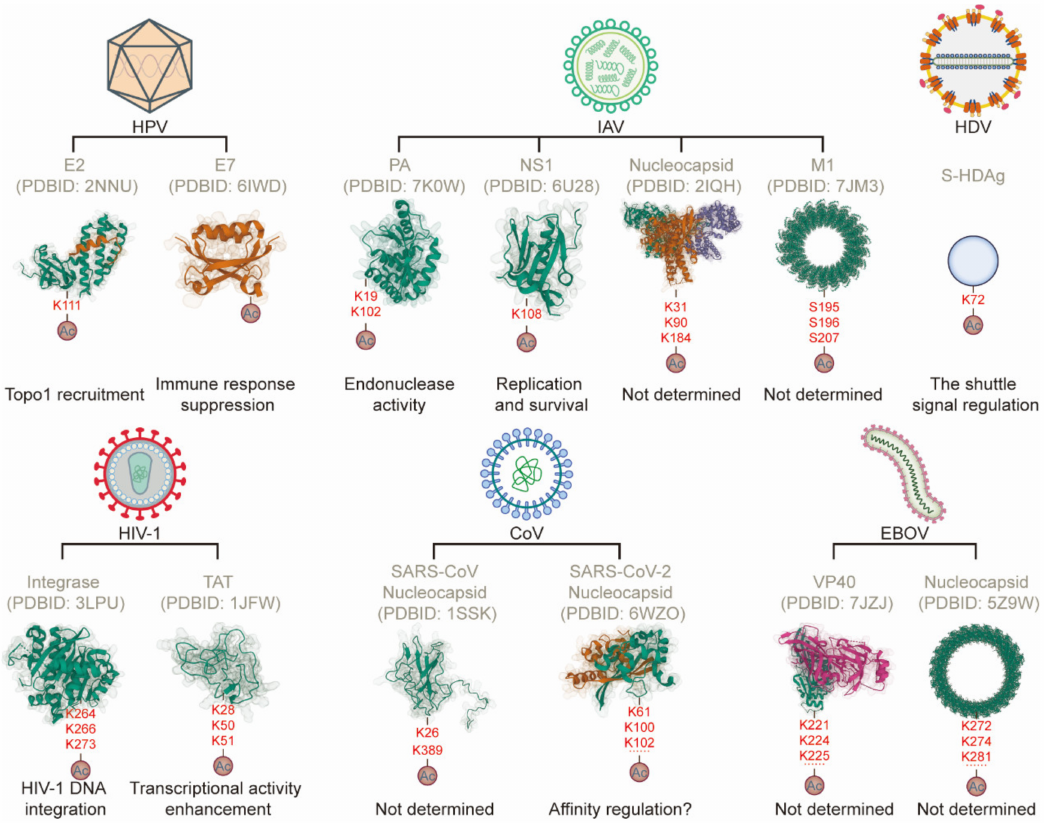
Figure 2. Effect of acetylation of viral proteins during viral infection. Representative acetylation of viral proteins and their function during virus–host interaction. The 3-D structures for the viral proteins were retrieved from the PDB database (PDB accession numbers 2NNU, 6IWD, 7K0W, 6U28, 2IQH, 7JM3, 3LPU, 1JFW, 1SSK, 6WZO, 7JZJ, and 5Z9W). The acetylation chains are representative of hypothetical